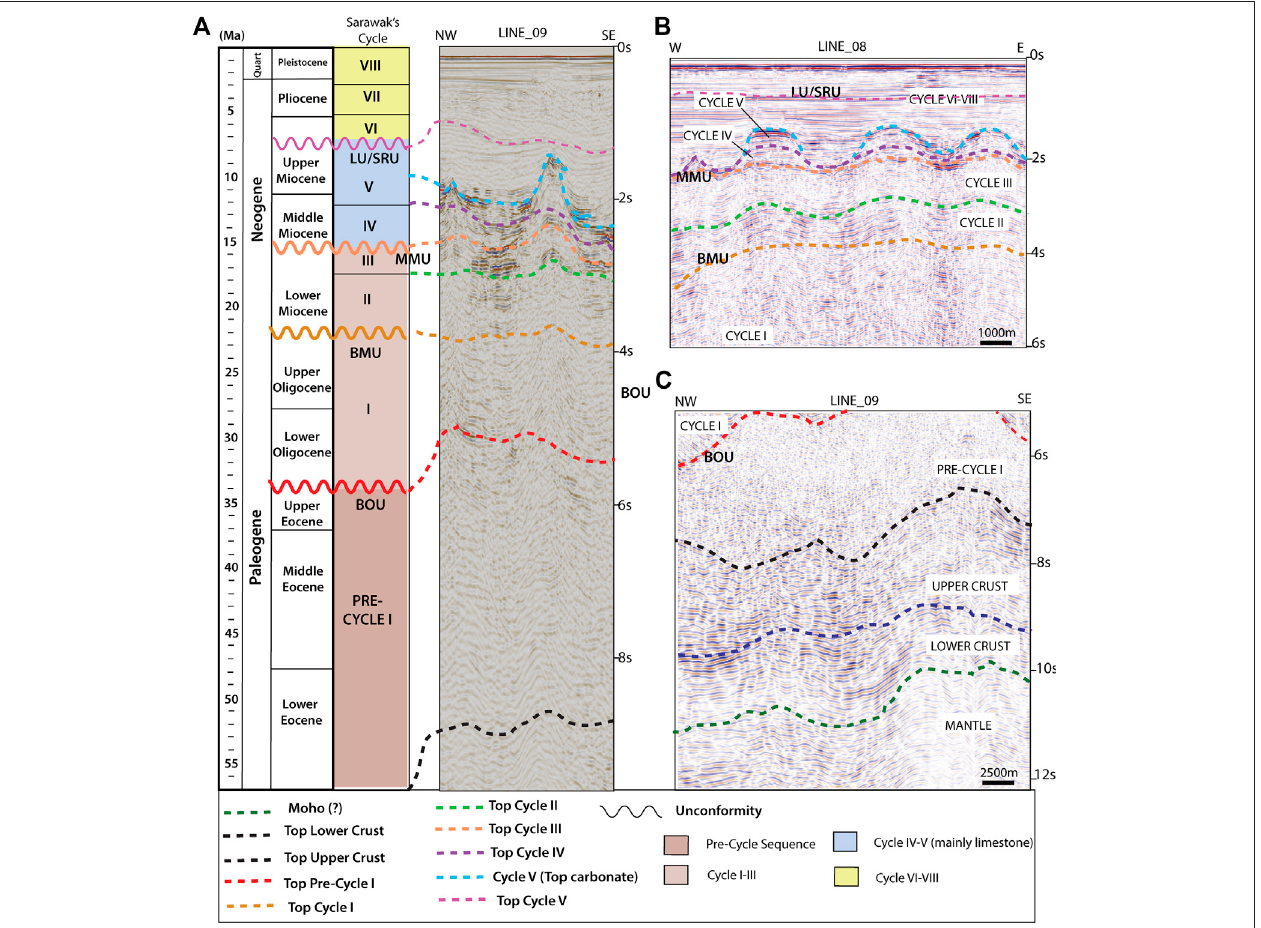
FIGURE 2 | (A) Seismo-stratigraphy chart of this study correlated with Sarawak ’ s stratigraphy based on Ho (1978) and Hageman et al., (1987). Four major unconformities are base Oligocene Unconformity (BOU), base Miocene Unconformity (BMU), Middle Miocene Unconformity (MMU) and Lapan Unconformity(LU) which isequivalenttoShallowRegionalUnconformity(SRU). (B) HorizonsandseismicfaciesforCycleItoCycleVIII. (C) Horizonsandseismicfaciesforthemantle,lower-upper crust and Pre-Cycle I sequence.